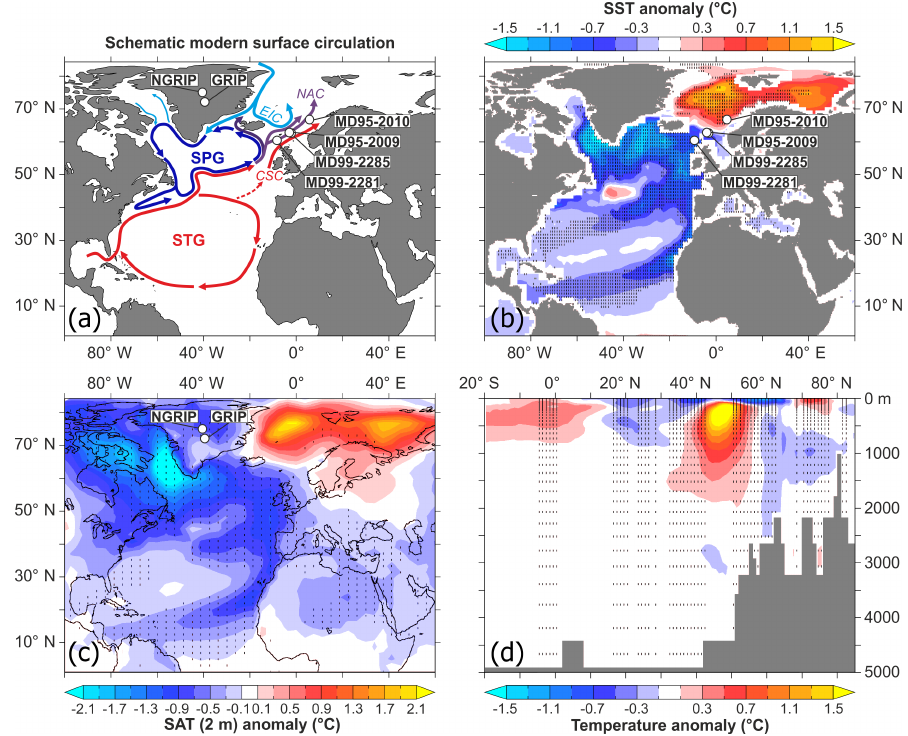
Figure 1. Hydrographical context and five-member ensemble mean of temperature anomalies between hosing and control experiments. (a) Schematic surface current pattern (STG, subtropical gyre; SPG, subpolar gyre; CSC, Continental Slope Current; NAC, North Atlantic Current; EIC, East Icelandic Current). (b, c) Five-member ensemble mean of SST (b) and surface atmospheric temperature (c) anomalies ( ◦ C). (d) Latitude–depth section of the five-member ensemble mean of oceanic temperature anomalies ( ◦ C, zonal average over the Atlantic Ocean). Also shown are the locations of the studied marine cores (MD95-2010, MD95-2009, MD99-2285, MD99-2281) and Greenland ice cores (NGRIP, GRIP). Black dashes indicate grid points where all models converge on the anomaly